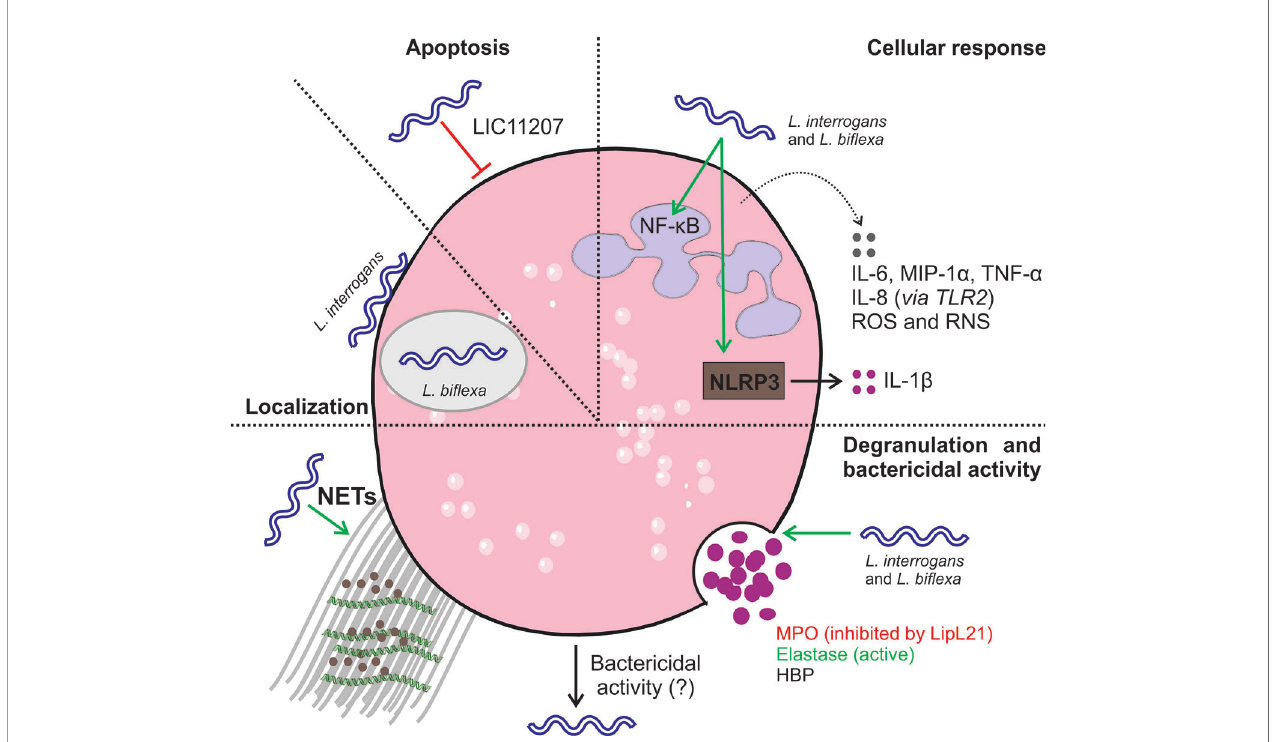
FIGURE 3 | Interaction of L. interrogans and neutrophils. Upon infection, leptospires are observed at the neutrophil surface or intracellularly in vacuoles. Live pathogenic leptospires seem to be resistant to internalization unless they are opsonized. In contrast, saprophytic leptospires are rapidly internalized and killed (13, 54, 55). Leptospires do not trigger apoptosis (58, 59), and they have an anti-apoptotic effect on infected cells (55). Intracellular uptake of leptospires triggers cellular responses characterized by the production of antibacterial components such as reactive oxygen species (ROS) and reactive nitrogen species (RNS) (54, 55, 57, 58, 61, 62, 64). In addition, infection triggers TLR2-mediated production of IL-8 and NLRP3-dependent production of IL-1 b (55). Moreover, infection triggers the production of other antibacterial mediators, such as cytokines and chemokines (55, 57), but does not induce or inhibit neutrophil myeloperoxidase (MPO) activity (55, 60). Cellular responses tend to be more robust for live leptospires than heat- or formalin-inactivated leptospires (54, 55, 60, 63). Moreover, infection triggers the production of neutrophil extracellular traps (NETSs) (57). The bactericidal activity of neutrophils has not always been observed, and it seems to be dependent on the sources of cells, the serovar used, and the use of opsonizing antibodies (13, 55, 57,